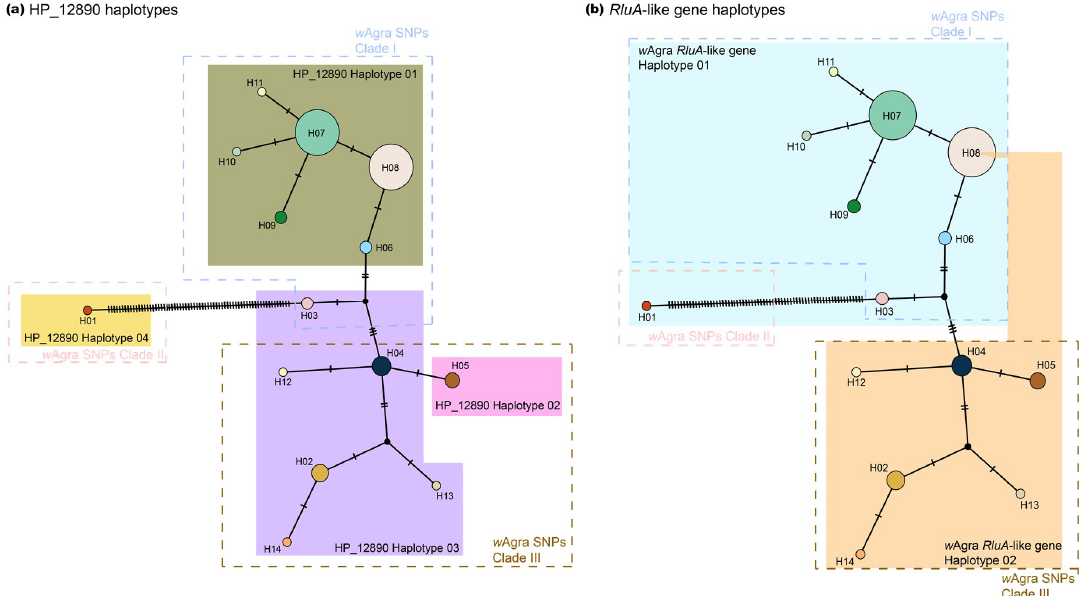
Figure 3. Mitochondrial COI haplotypes of A . gracilipes (circles in color) and their corresponding Wolbachia ( a ) HP_12890, and ( b ) RluA -like gene haplotypes. Dashed lines indicate the w Agra SNPs clade shown in Figure 2a. Circle area is proportional to the number of individuals carrying a given